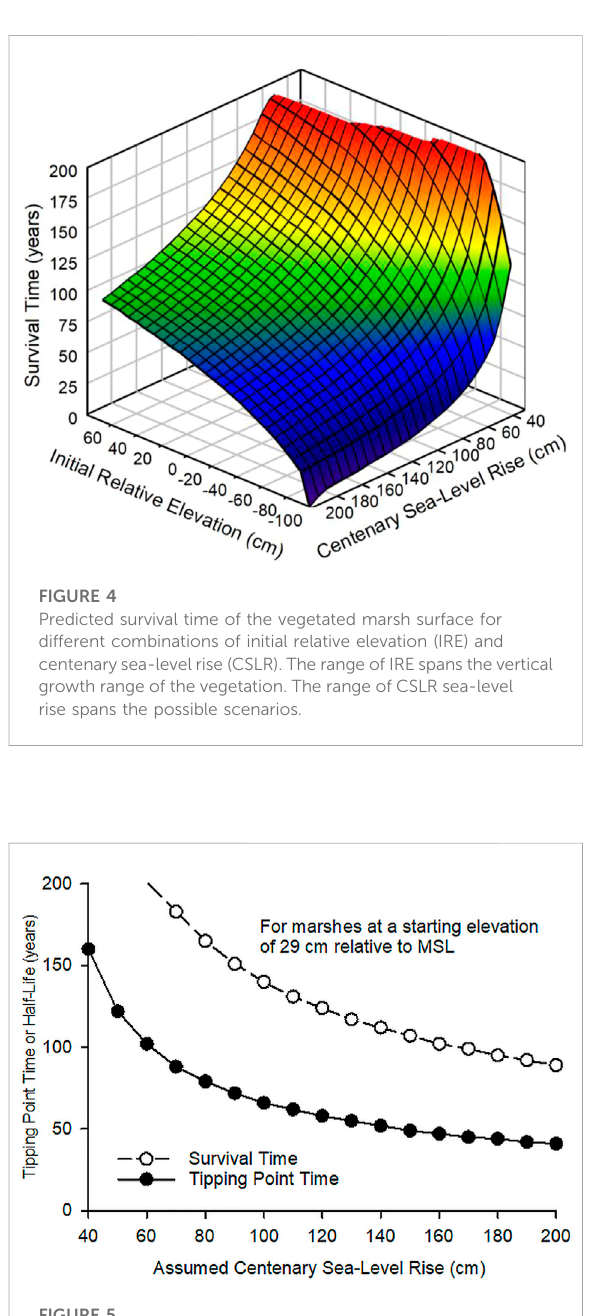
FIGURE 5 Survivalandtippingpointtimes(TPTs)foraDeltamarshatthe average elevation (29 ± 23 cm rel. MSL) of the ground surface of the cores collected throughout the